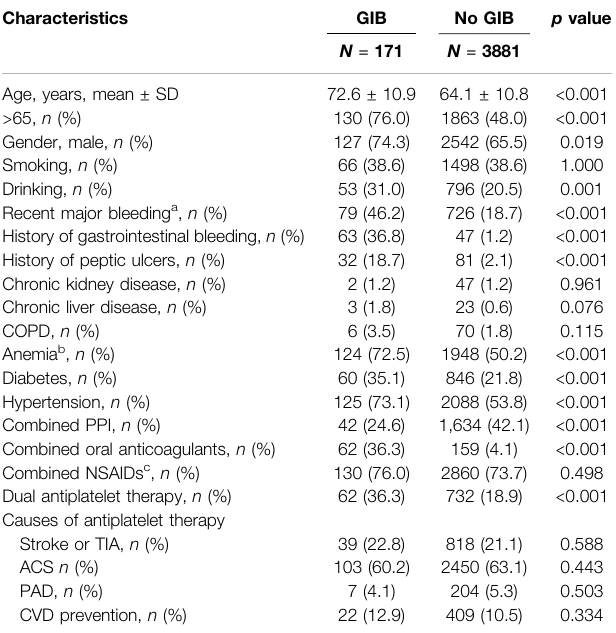
TABLE 1 | Baseline clinical characteristics of patients.